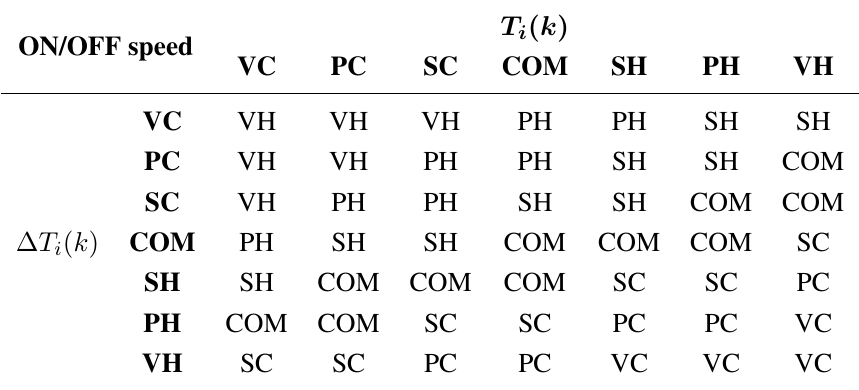
Table 8. Fuzzy inference rules of